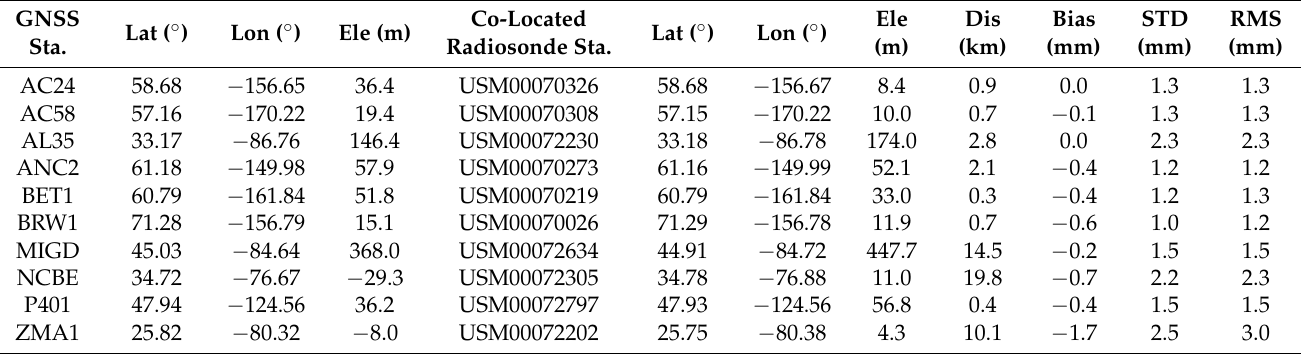
Table 2. Statistical results of GNSS-PWV over each GNSS station during the 11-year period studied using RS-PWV over the co-located radiosonde station as the